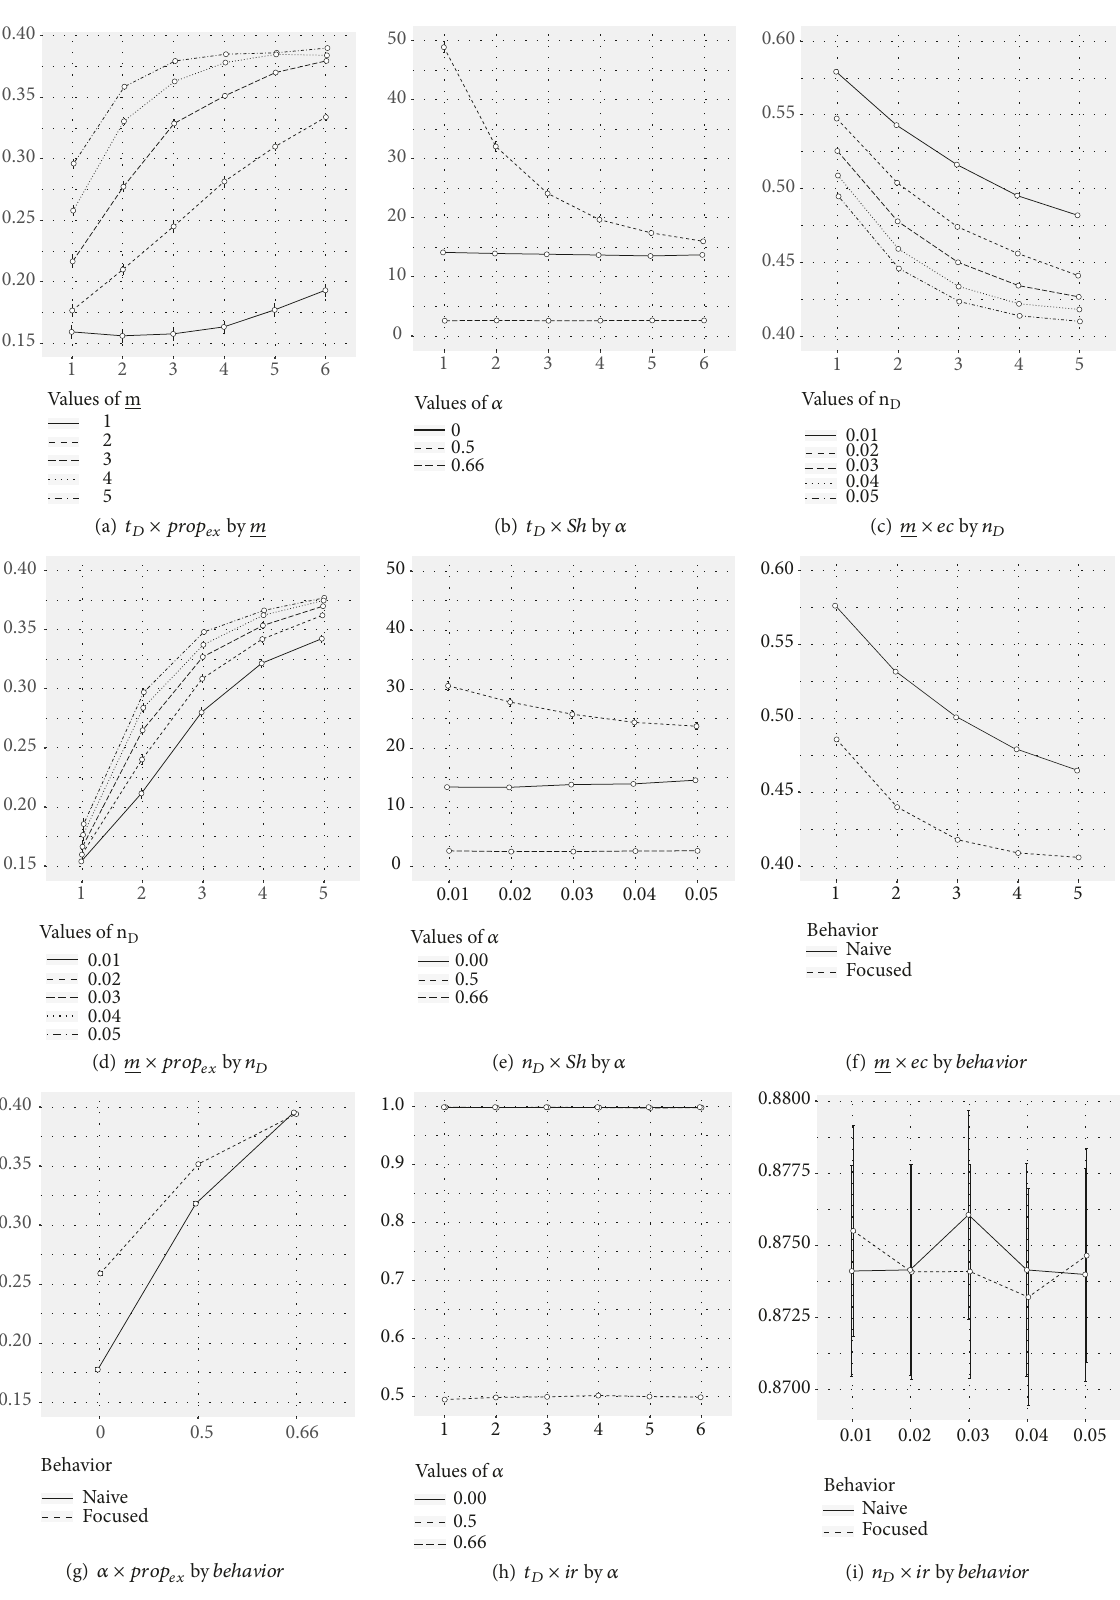
Figure 9: Curves of mean observations for different parameters and metrics for 36,000 runs. Bars are 0.95 confidence intervals. Plots with the same observables (ordinate), except for 𝑖𝑟 , are on the same